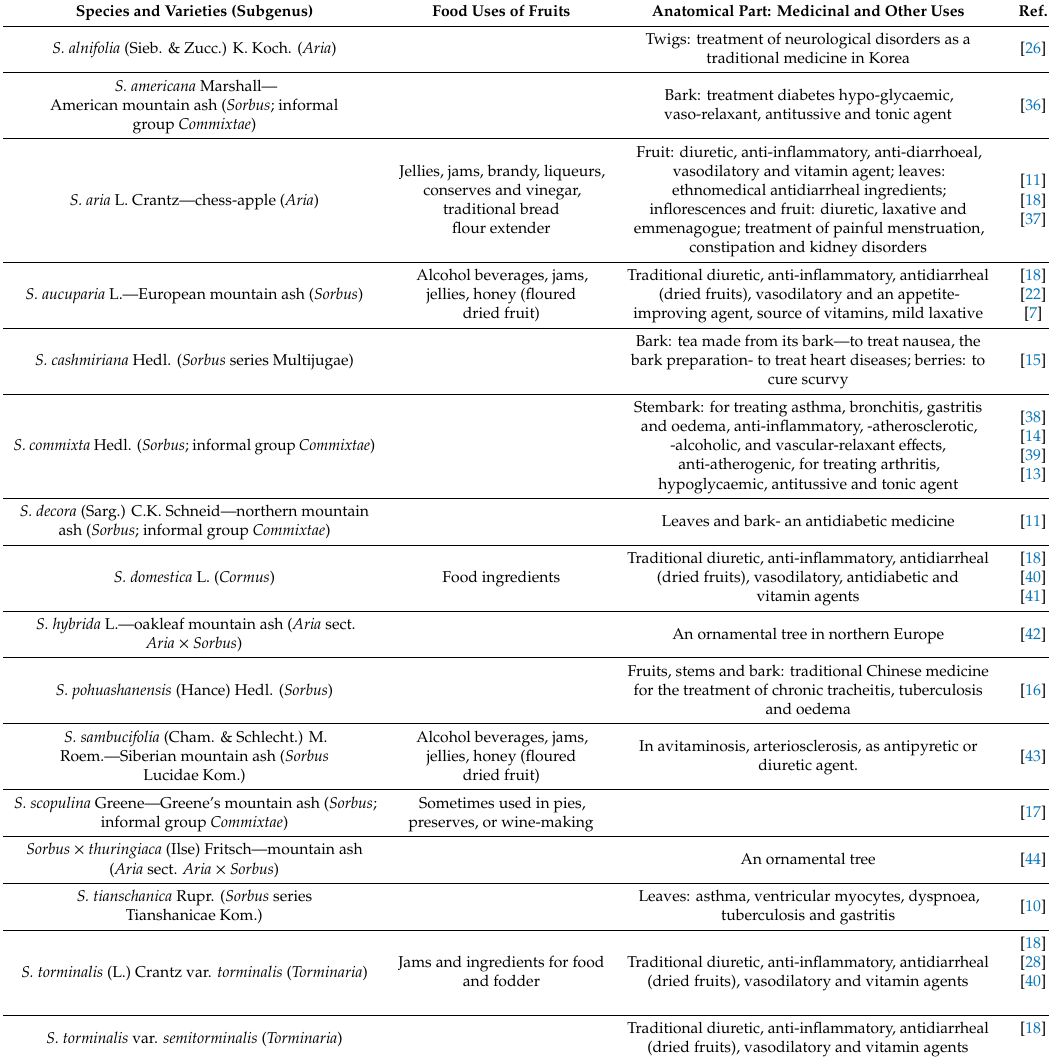
Table 1. Botanical classification of selected Sorbus spp. and their uses. Species and Varieties (Subgenus)